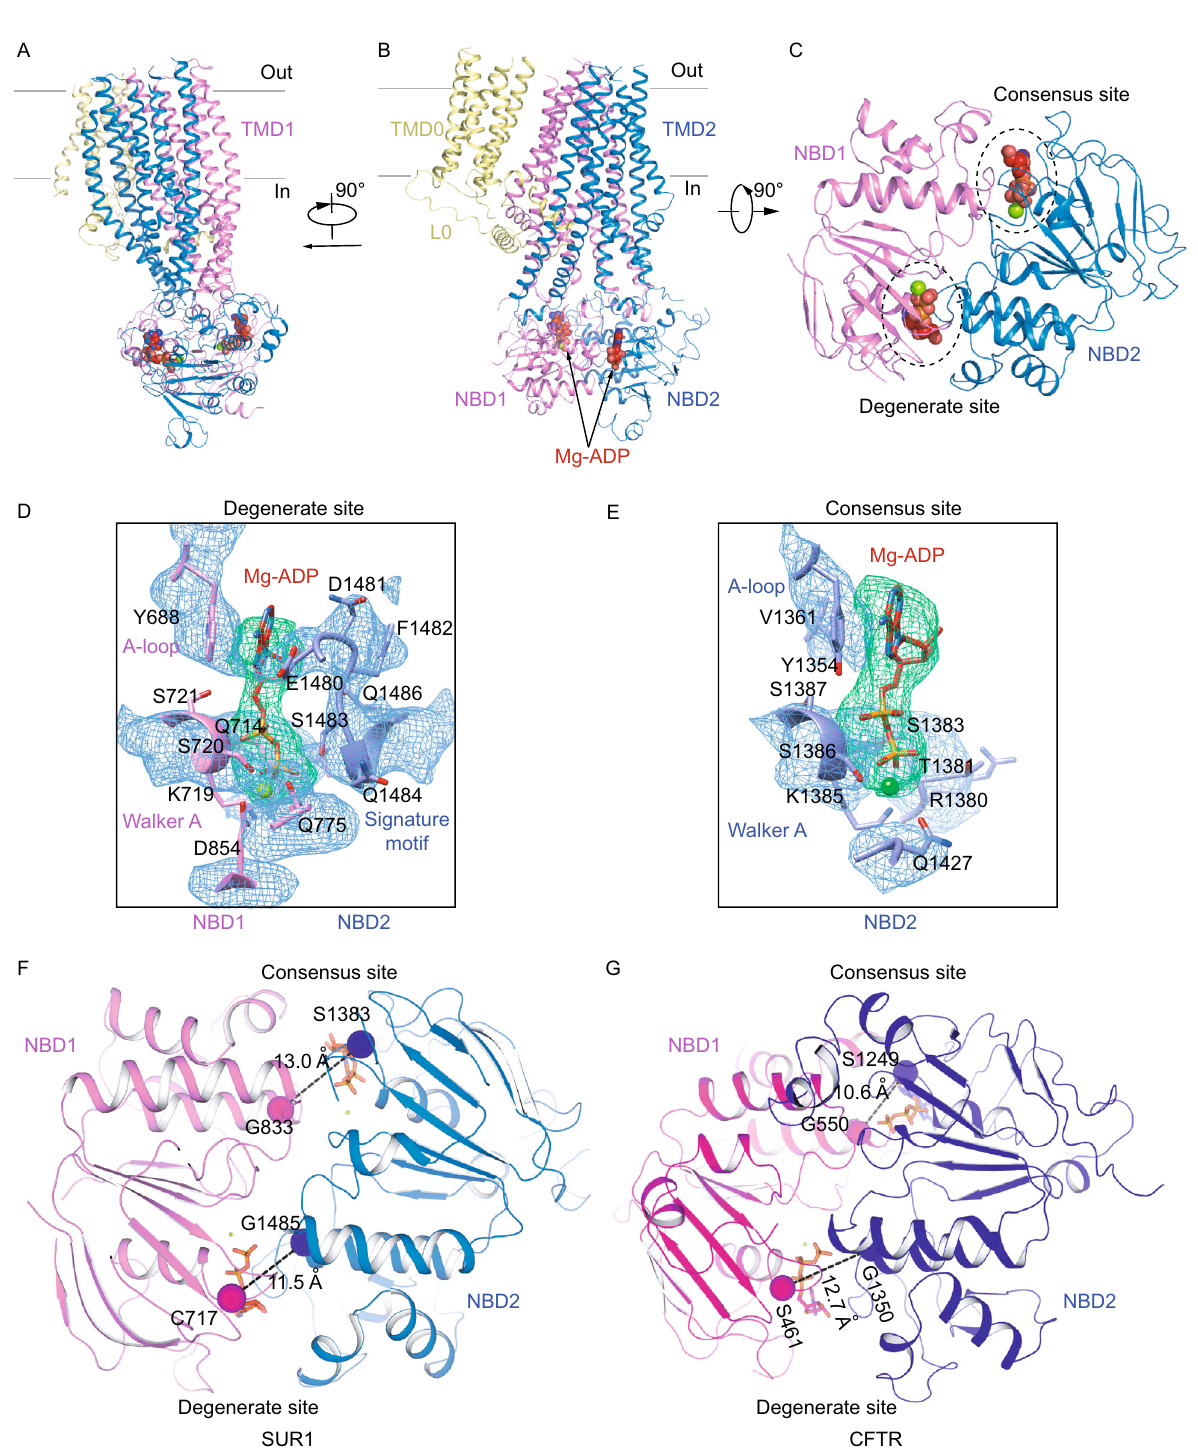
Figure 4. Mg-ADP on SUR1. (A) Side view of a single SUR1 subunit in cartoon representation. Color scheme is the same as in Fig. 1A. Mg 2+ and ADP are shown as green and red spheres, respectively. (B) Side view of a single SUR1 subunit with a 90° rotation relative to panel (A). (C) Bottom view of a single SUR1 subunit with a 90° rotation relative to (B). For simplicity, only NBD1 and NBD2 are shown. Two Mg-ADP molecules are circled. (D and E) EM densities at the degenerate site (D) and consensus site (E), colored as in Fig. 2H. Mg 2+ is shown as a green sphere. (F and G) Differences of NBD closures in SUR1 (F) and CFTR (PDB: 5W81) (G). C α distances between the glycine in the Walker A motif and serine (cysteine instead at the degenerate site of SUR1) in the ABC signature motif are shown as dashed